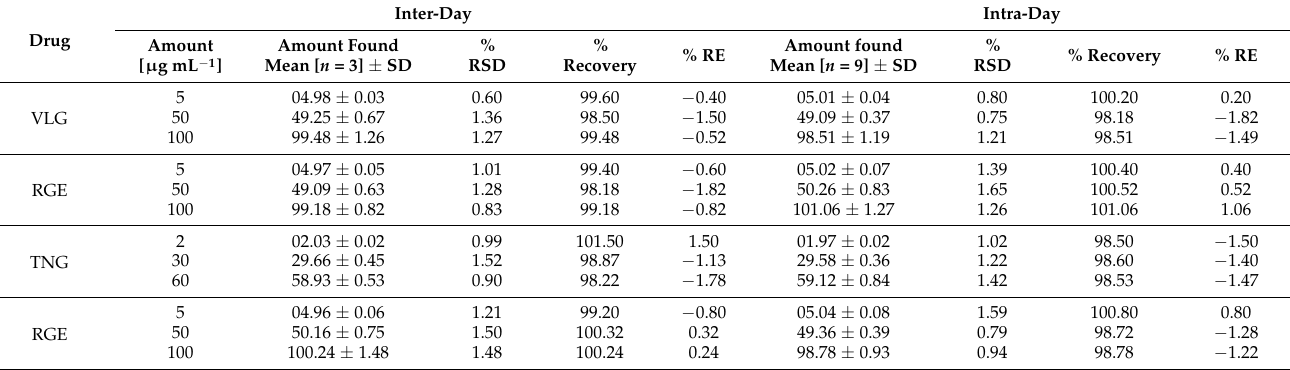
Table 4. Precision and accuracy